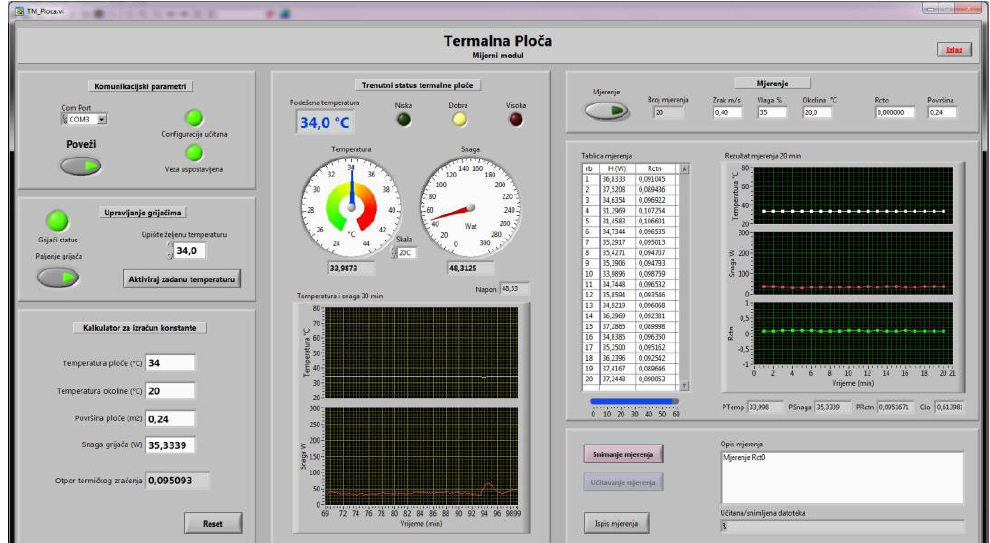
Figure 5. The display of the computer monitor for controlling and measuring the measurement plate.